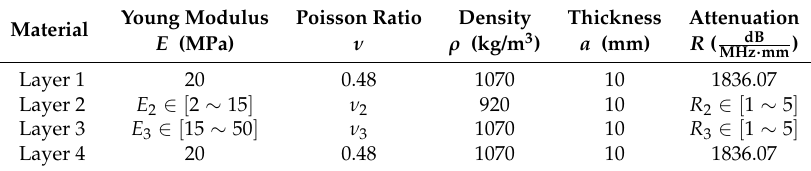
Table 3. Parameters of the layered soft tissue. Poisson’s ratio depends on E